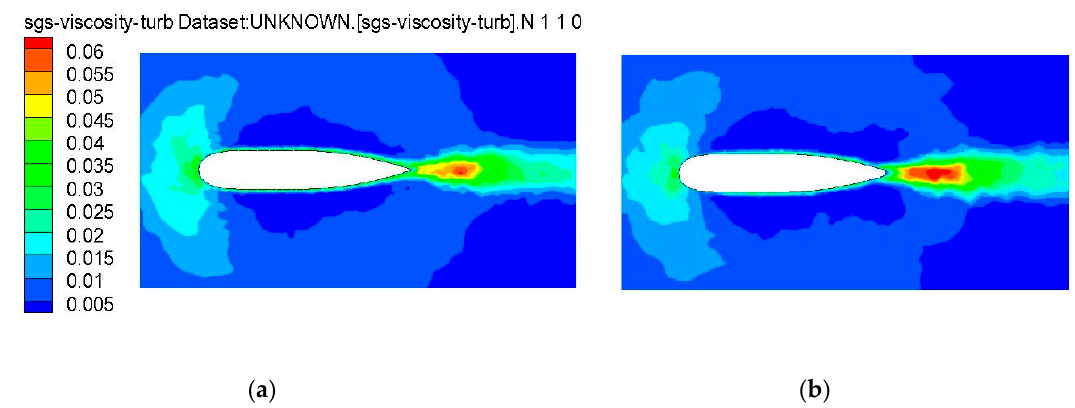
Figure 12. The wake flow field of the two models. ( a ) The original model; ( b ) the model with the mechanical VGs.